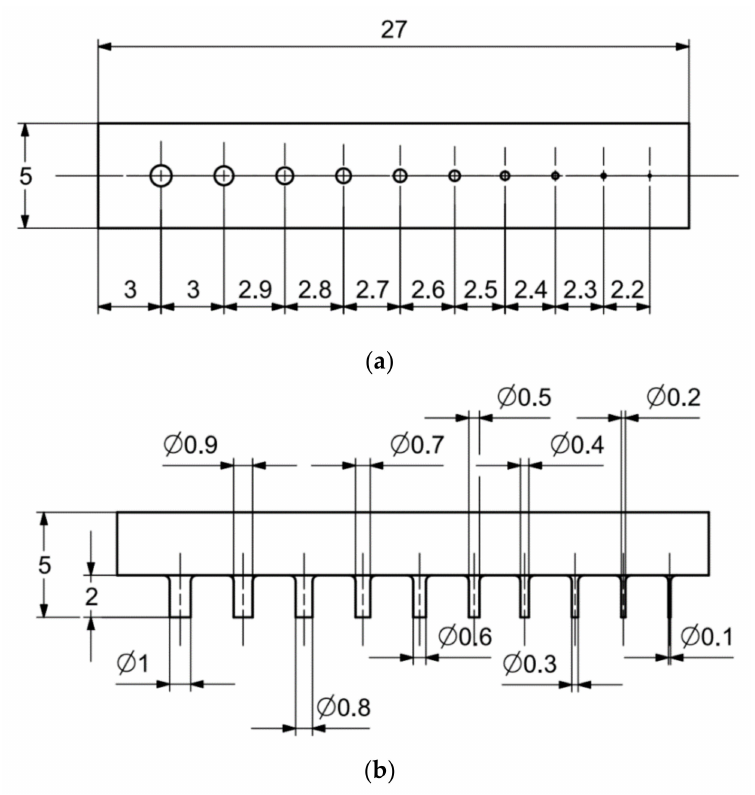
Figure 7. ( a ) The illustrative drawing of samples covered by the research is marked as MB2. ( b ) The top view of cylinders Ø1–Ø0.1 mm based on Figure 7a of the main view of an illustrative drawing of samples covered by the research is marked as